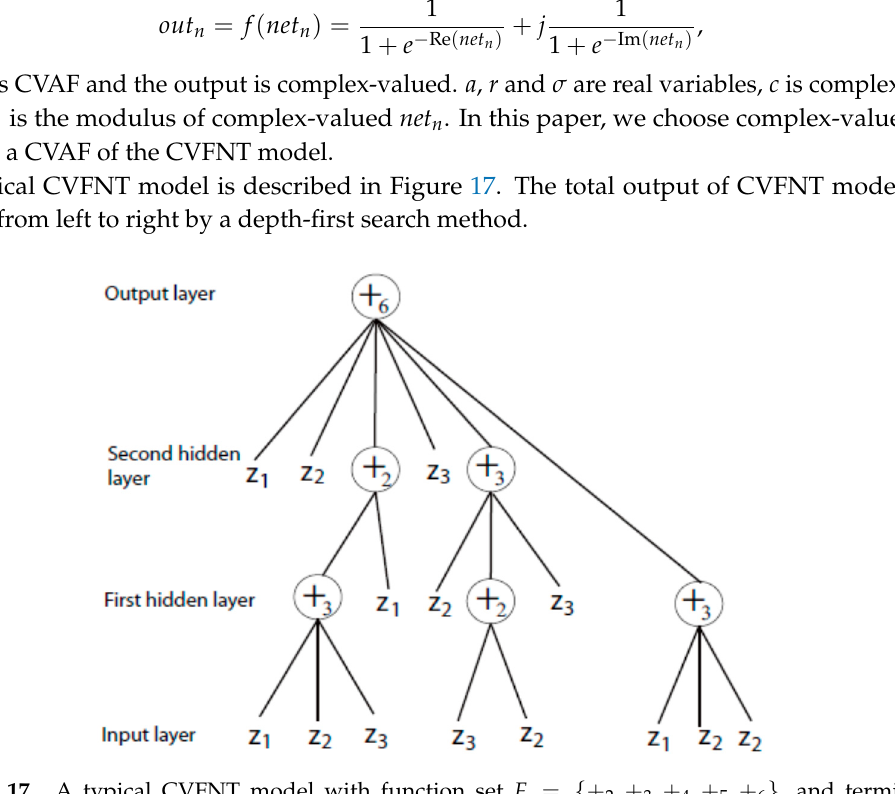
Figure 18. The flowchart of an HSCVFNT algorithm.